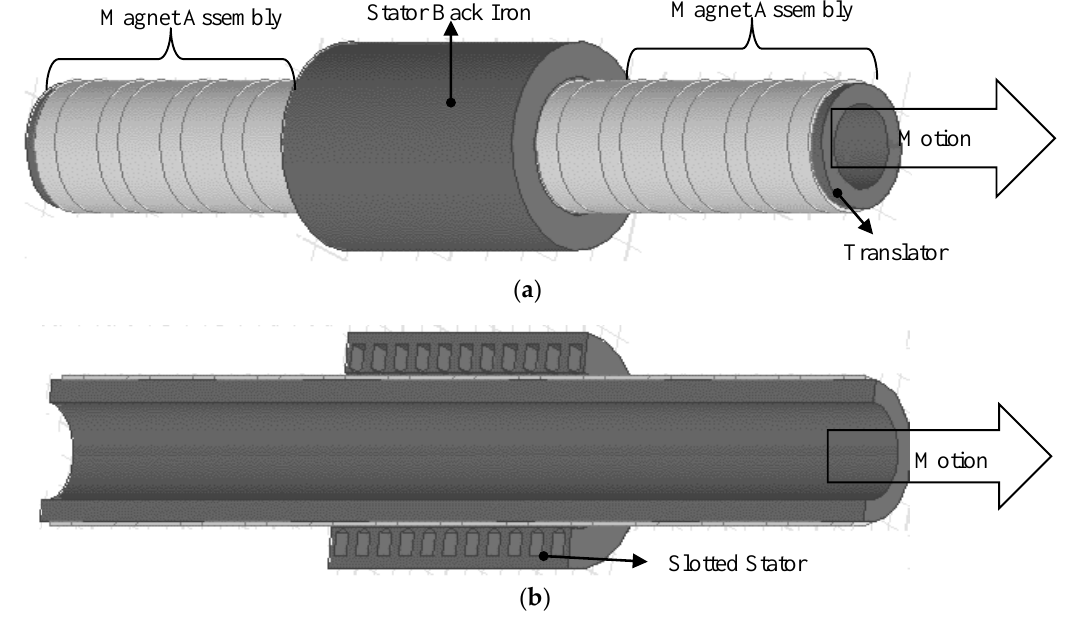
Figure 2. 3-dimension TPMLM Conceptual Design: ( a ) Full Design; ( b ) Cross Section.